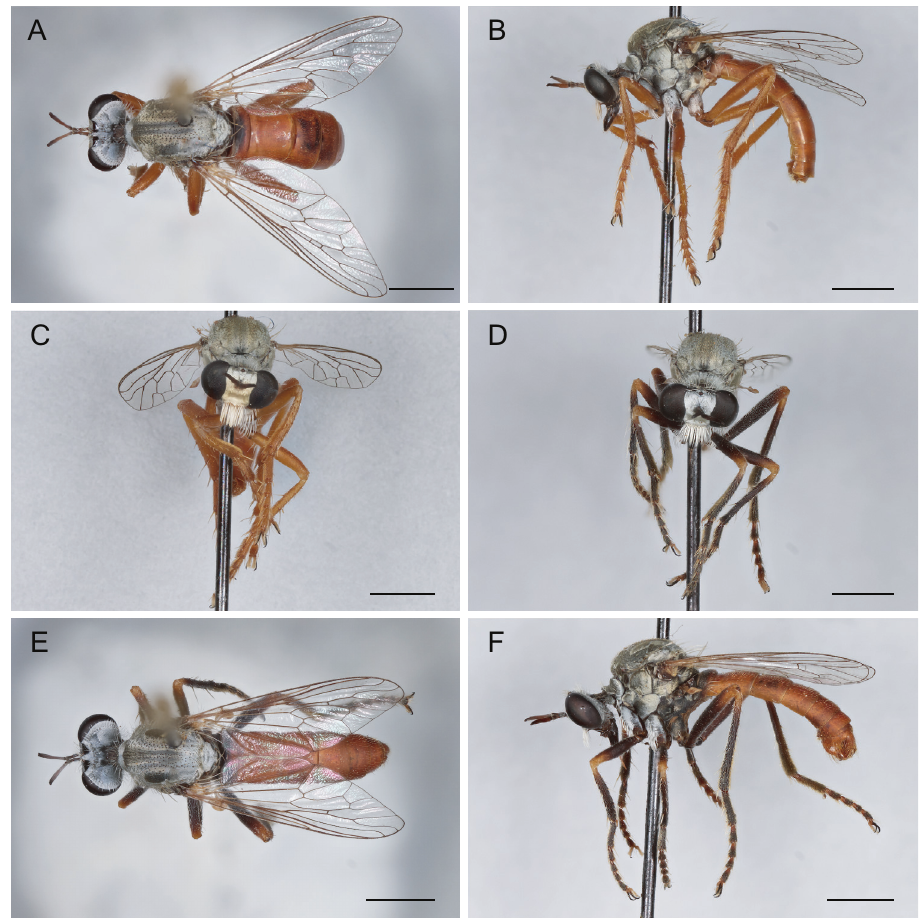
Figure 28. Saropogon semiustus Coquillett, 1904 Female (USNMENT01830085): A dorsal view B lateral view C anterior view; Male (USNMENT01830084): D anterior view E dorsal view F lateral view. Scale bars: 2